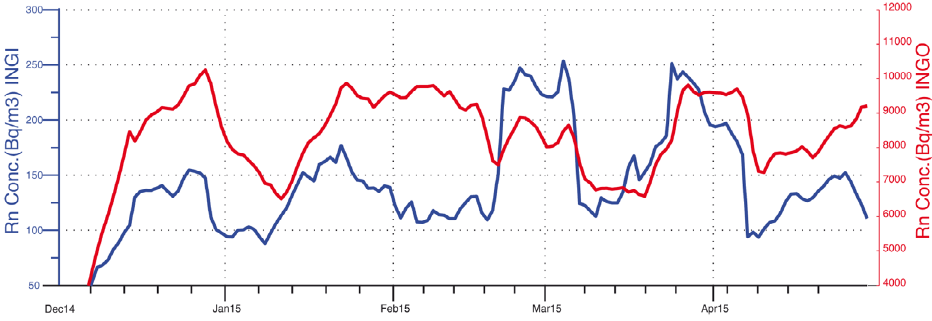
Figure 1A. 15-days moving averaged time series of the radon concentration from INGI (blue line) and INGO (red line) stations during the period from January 2015 to April 2015.